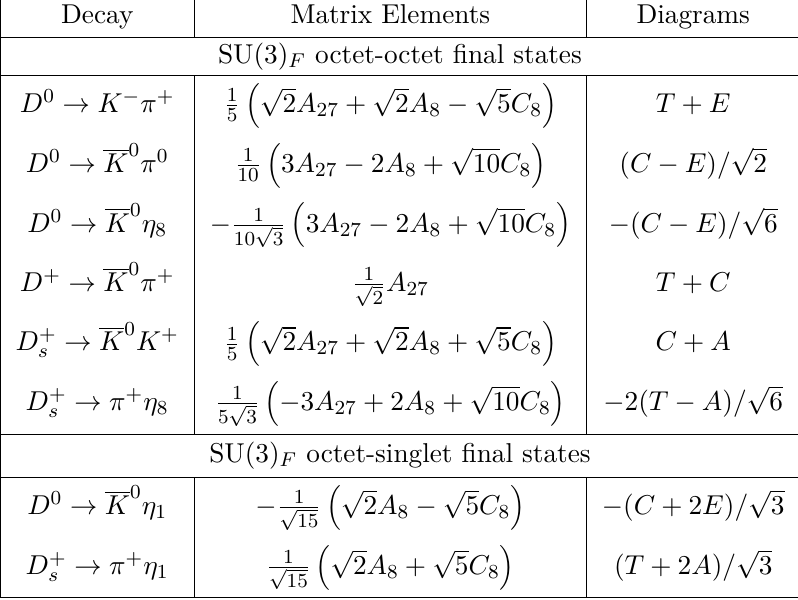
Table 6. Amplitudes for CF D → PP processes using the SU(3) F matrix-elements and flavor- flow representations. We have separated decays to final states involving octets only and those also involving singlets. Overall factors containing G F and V CKM , that are identical in both representa- tions, have been left out for